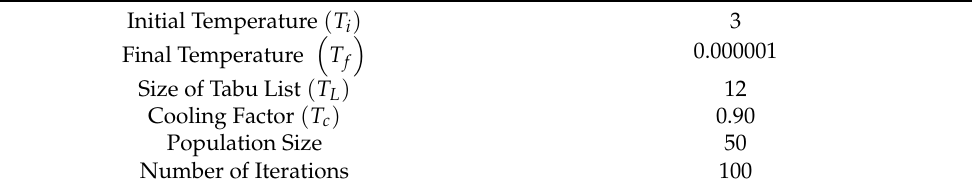
Table 1. Initial values of HTSA.